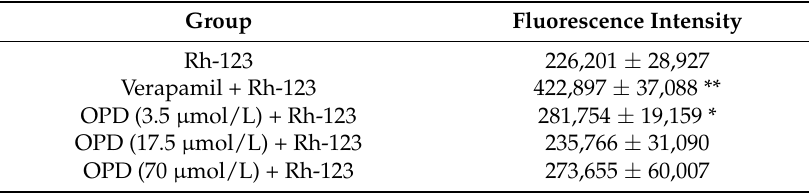
Table 4. Effect of OPD on the accumulation of Rh-123 ( x ± s , n = 3).